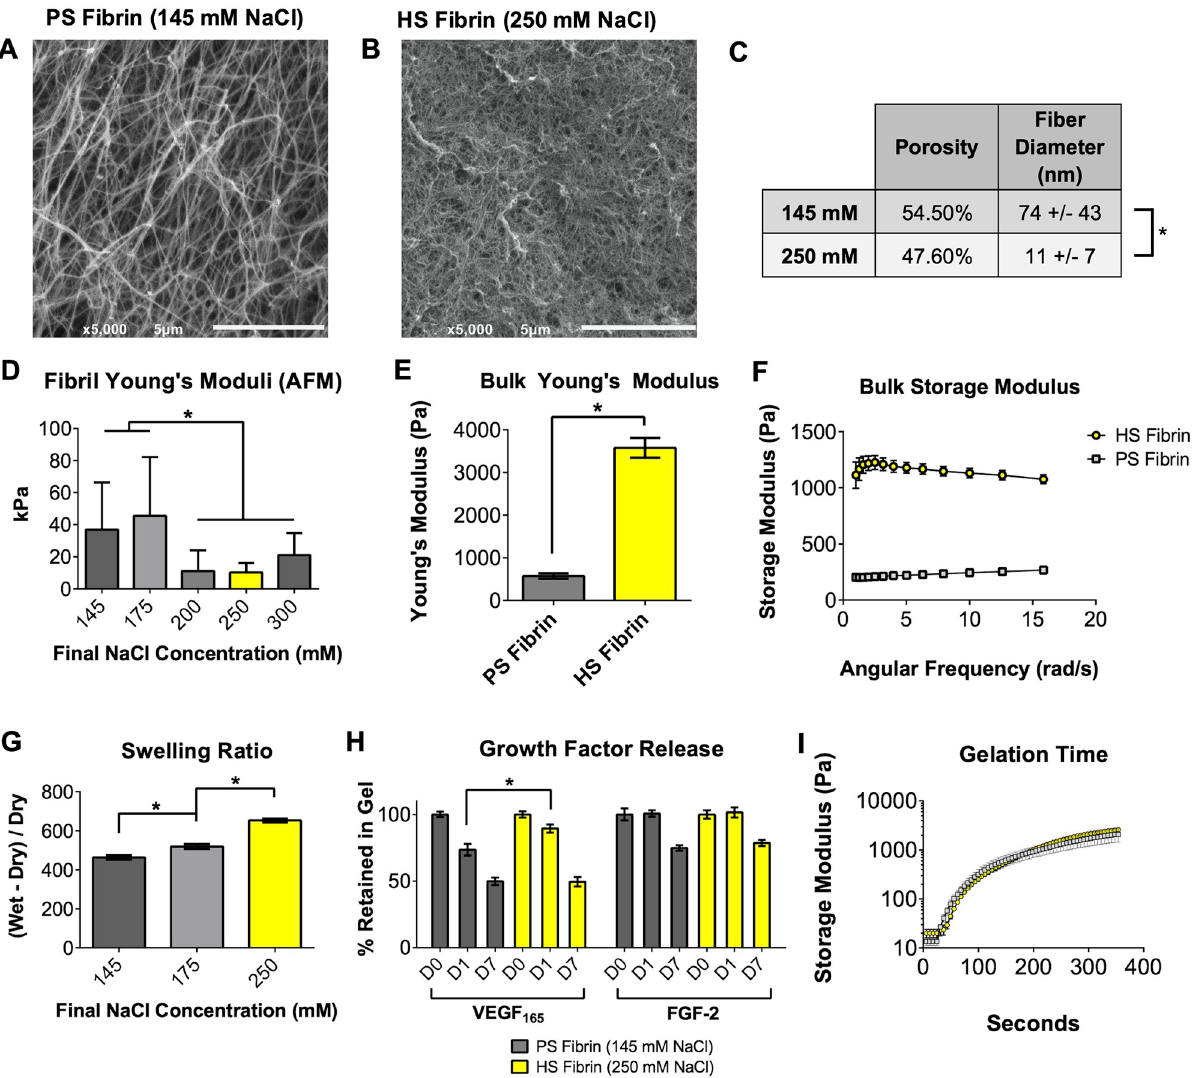
Fig 2. Changing salinity of fibrinogen solution alters fibrin gel properties. SEM images of fiber morphology (A, B) reveal that increasing salt concentration decreases porosity and fiber size (C). Young’s moduli of individual fibers measured by AFM (D), Young’s and Storage Modulus of the bulk materials measured by parallel plate rheometry (E,F), Swelling Ratio (G), and growth factor sequestering (F) are also significantly affected by salinity during gelation.